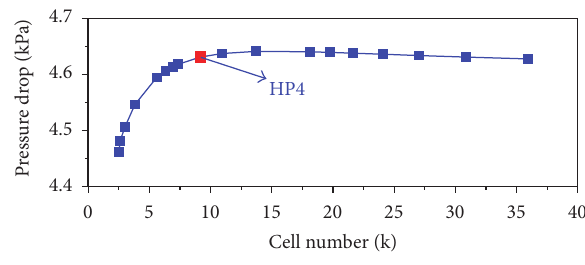
Figure 7: Analysis on axial mesh size.